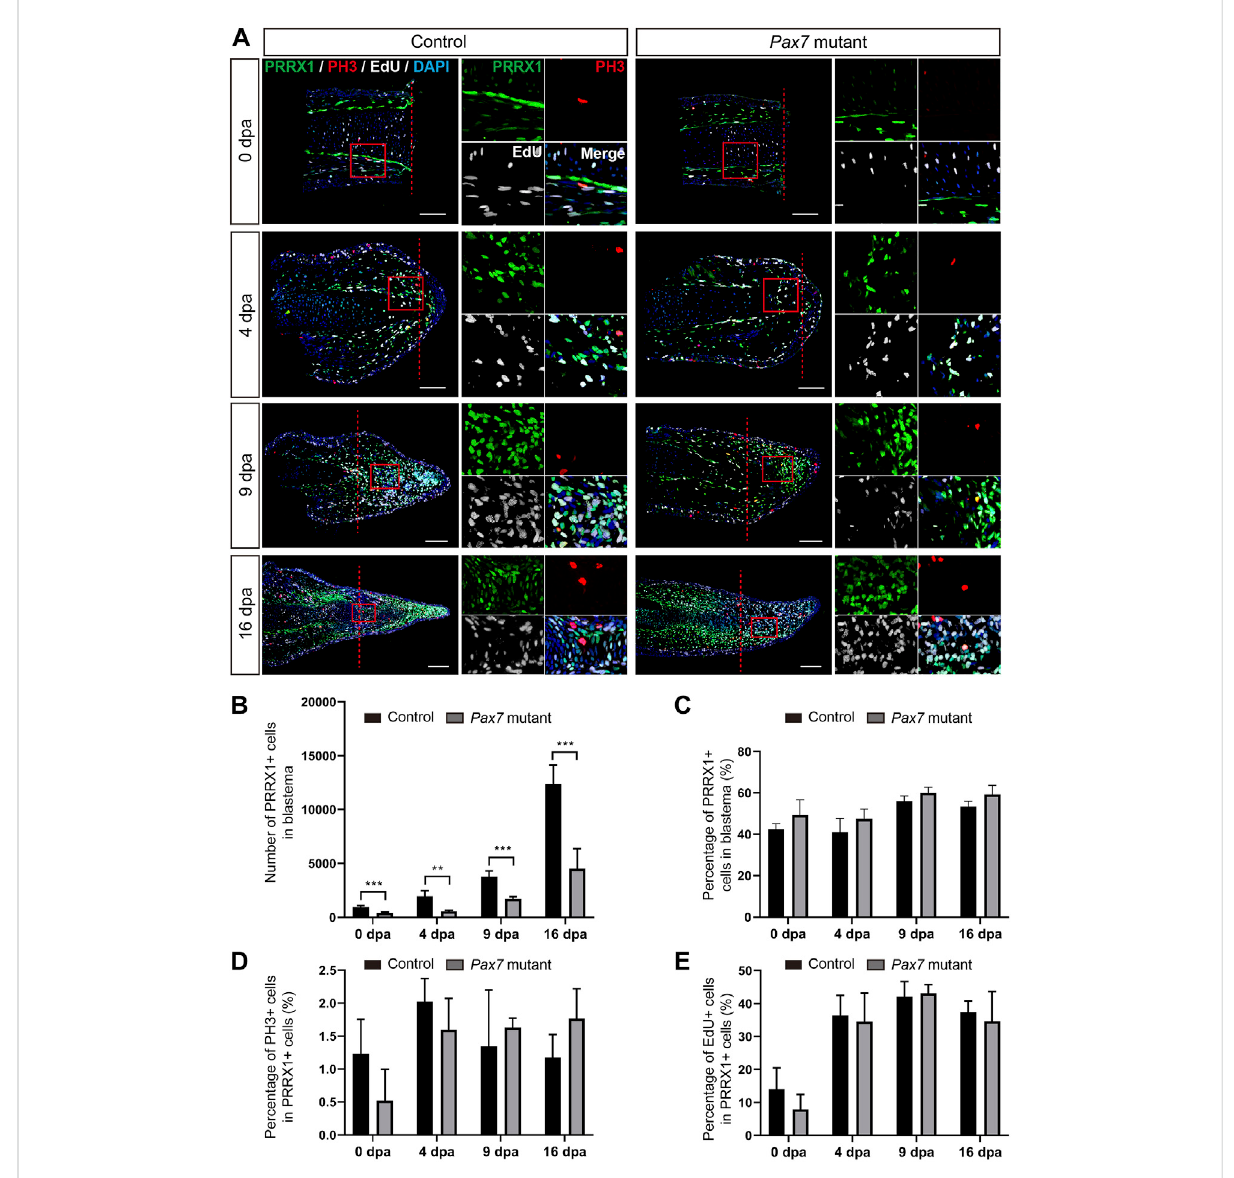
FIGURE 3 Fibroblast dynamics during limb regeneration in the absence of muscles. (A) Immuno fl uorescence images of PRRX1 (green), PH3 (red), combinedwithEdU(white)andDAPI(blue)staininginlimblongitudinal-sections,at0,4,9and16 dpa,fromcontroland Pax7 mutantanimals.Boxed regionsareshownathighermagni fi cationasseparatedchannels.Reddashedlines,amputationplanes.Scalebars,200 μ m. (B) and (C) Quanti fi cation of the absolute number (B) and the percentage (C) of PRRX1 positive cells, in the areas of the newly formed blastema combined 500 μ m zone proximaltotheamputationplane,at0,4,9and16 dpa,fromcontrols( n =4)and Pax7 mutants( n =4).Dataarepresentedasmean±sem,** p < 0.01, *** p < 0.001. (D,E) Quanti fi cation of the percentage of PH3- (D) and EdU- (E) positive cells, in PRRX1-positive cells quanti fi ed in (B)